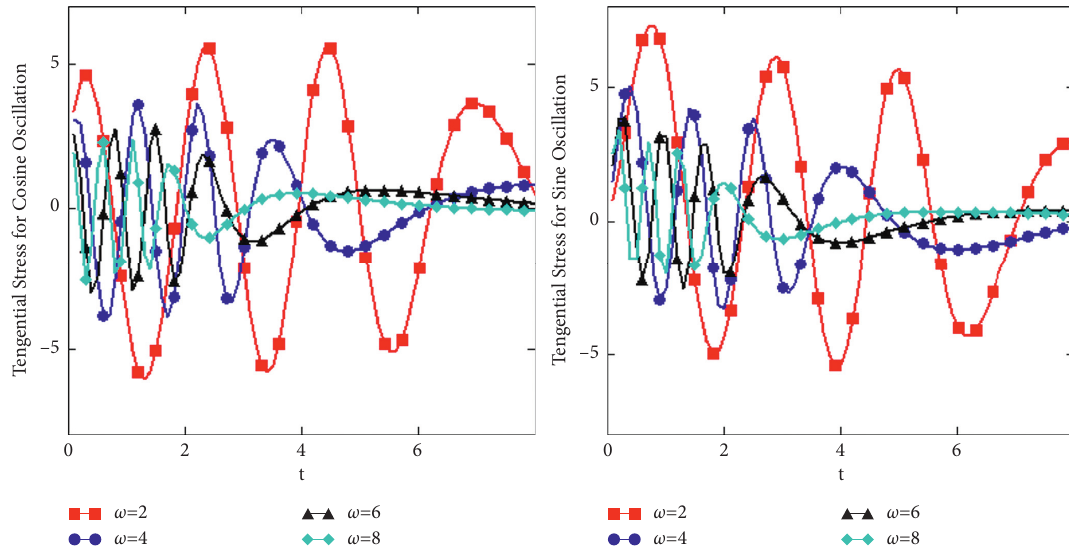
Figure 12: The variation of ω for both the oscillations with λ